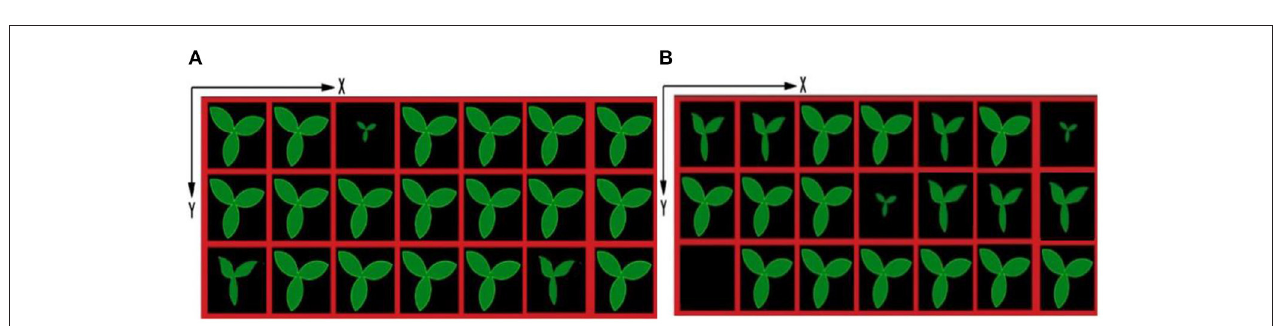
FIGURE 9 | Identification results based on the method in Tong et al. (2013).